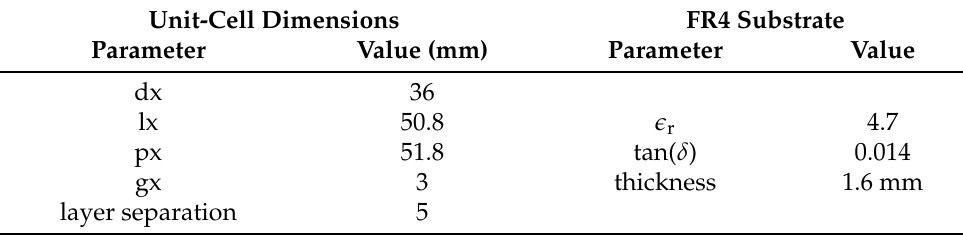
Table 1. Design parameters for transmitarray operating at 3.6